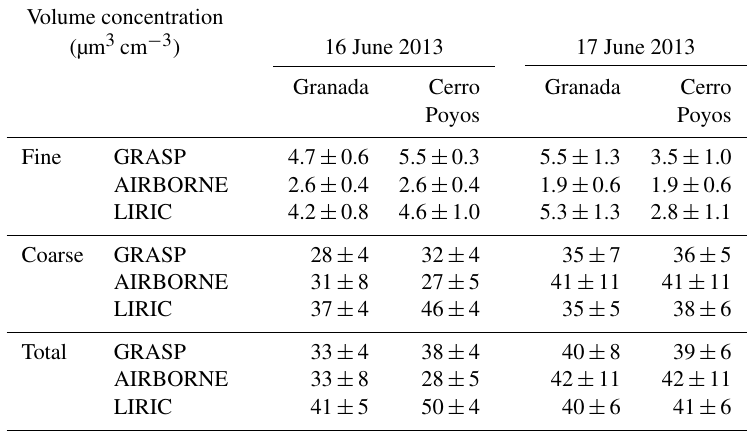
Table 4. Comparison of fine, coarse and total mean volume concentration (µm 3 cm − 3 ) retrieved by GRASP, measured by airborne and retrieved by LIRIC for dust layers on 16 June (up to 4.5kma.s.l.) and 17 June (from 2.6 to